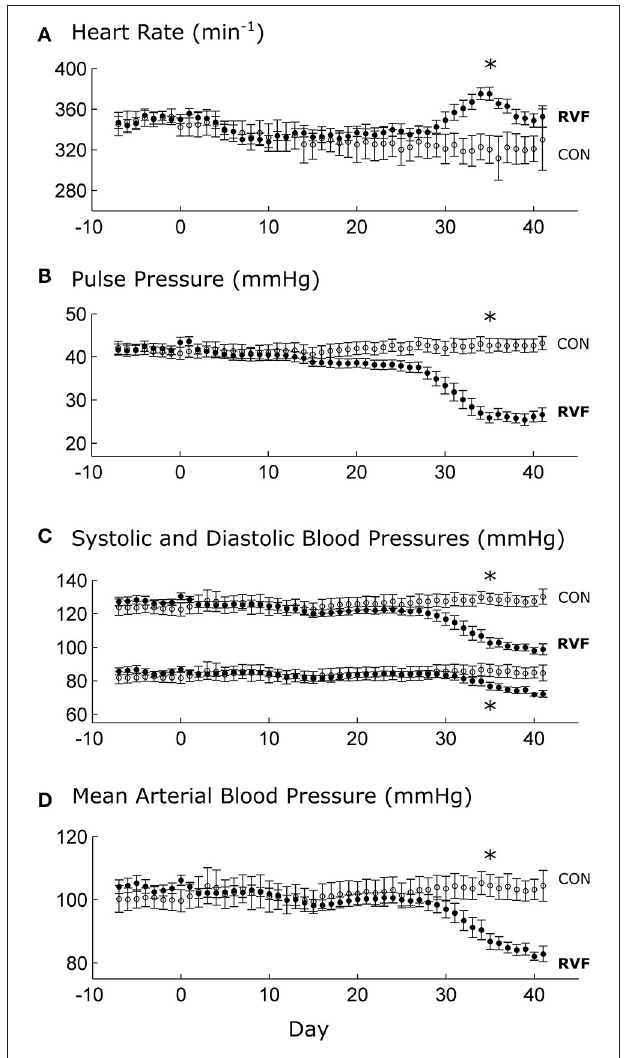
FIGURE 1 | Mean ± SE in vivo heart rate and blood pressures of control and right-ventricular failing rats as functions of time. Day 0 indicates injection of either monocrotaline or saline vehicle, following a week of baseline recording. At Day 28, significant differences (* P < 0.05) between RVF rats ( n = 8) and Control rats ( n = 6) begin to be evident in heart rate (A) , pulse pressure (B) , and blood pressures (C,D)